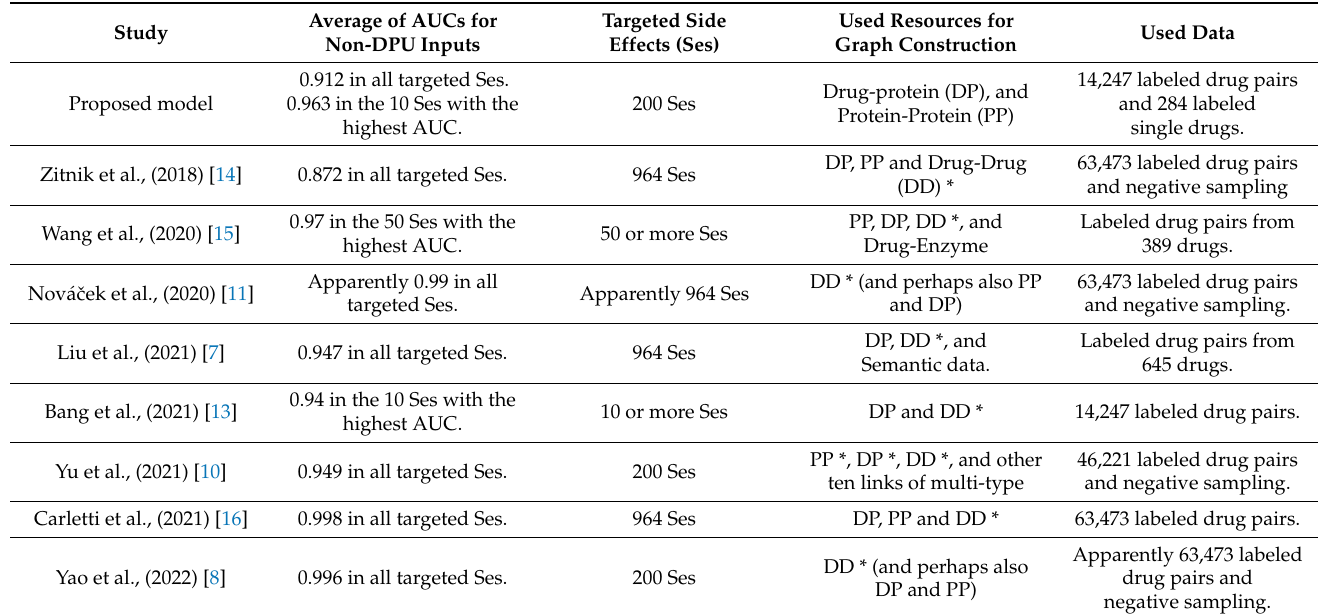
Table 4. Performance comparison with previous studies on non-DPU polypharmacy side effects